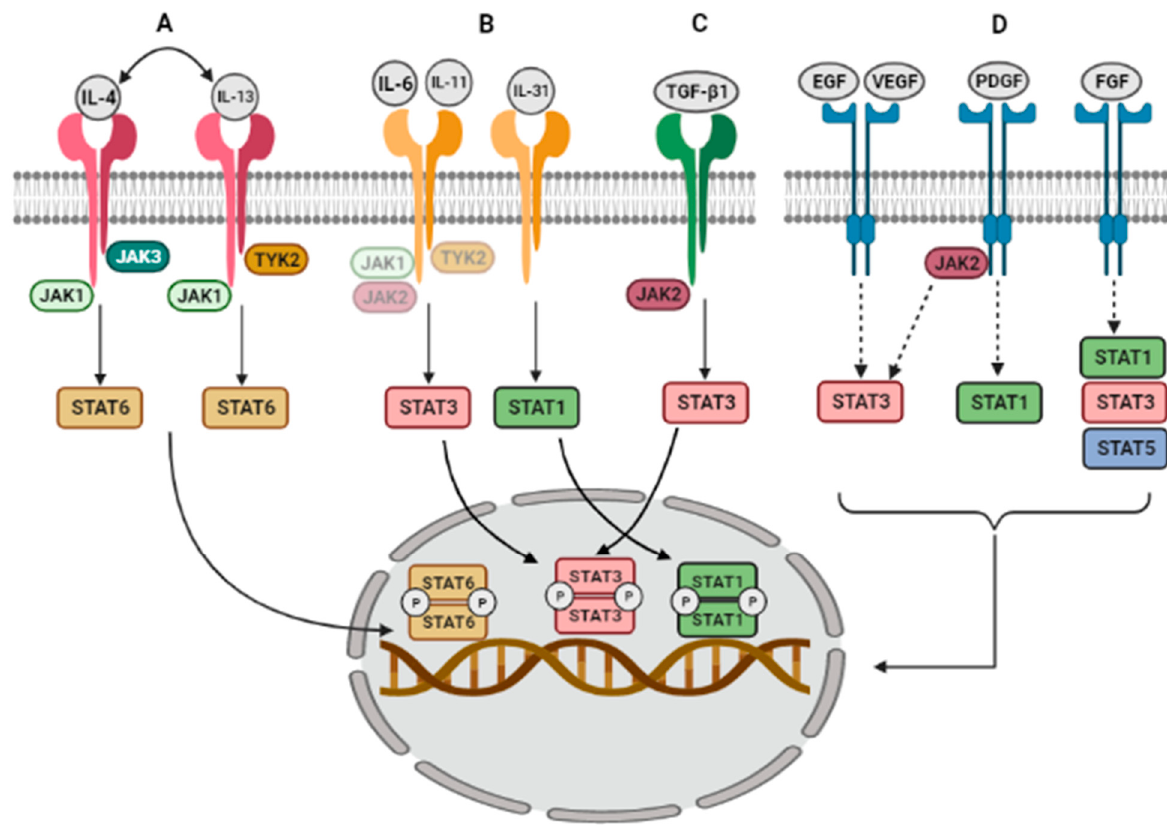
Figure 1. JAK/STAT activation and downstream signaling pathways in ILDs. ( A ) IL-4 binds to the type-I IL-4 receptor, constituted by the IL-4 receptor α chain (IL-4R α ) and the gamma chain ( γ c). Additionally, both IL-4 and IL-13 bind to the type II receptor made up of IL-4R α /IL-13R α 1. Stimulation of these receptors activates IL-4R α and associated JAK1 to phosphorylate STAT6 monomers, which then homodimerize and translocate to the nucleus when it activates fibrotic responses. ( B ) IL-6 and IL11 activate the receptor gp130. This receptor has shown binding to JAK1, JAK2, and TYK2 in other diseases; however, in ILDs, is not elucidated, which JAK induces the phosphorylation of STAT3. The same happens after gp130 stimulation by IL-31, which leads to STAT1 activation. Then, both STAT3 and STAT1 travel dimerized to the nucleus. ( C ) Non-canonical activation of TGF- β 1 signaling pathway starts with its binding to the TGF- β 1 receptor, and then the phosphorylation of JAK2 occurs, leading to STAT3 activation and homodimerization. ( D ) Indirect evidence of JAK/STAT pathway activation by growth factors. Here, there are represented the different JAKs and STATS found activated after stimulation of each receptor with epidermal growth factor (EGF), vascular endothelial growth factor (VEGF), platelet-derived growth factor (PDGF), and fibroblast growth factor (FGF) in other diseases different to ILD. The image was created with